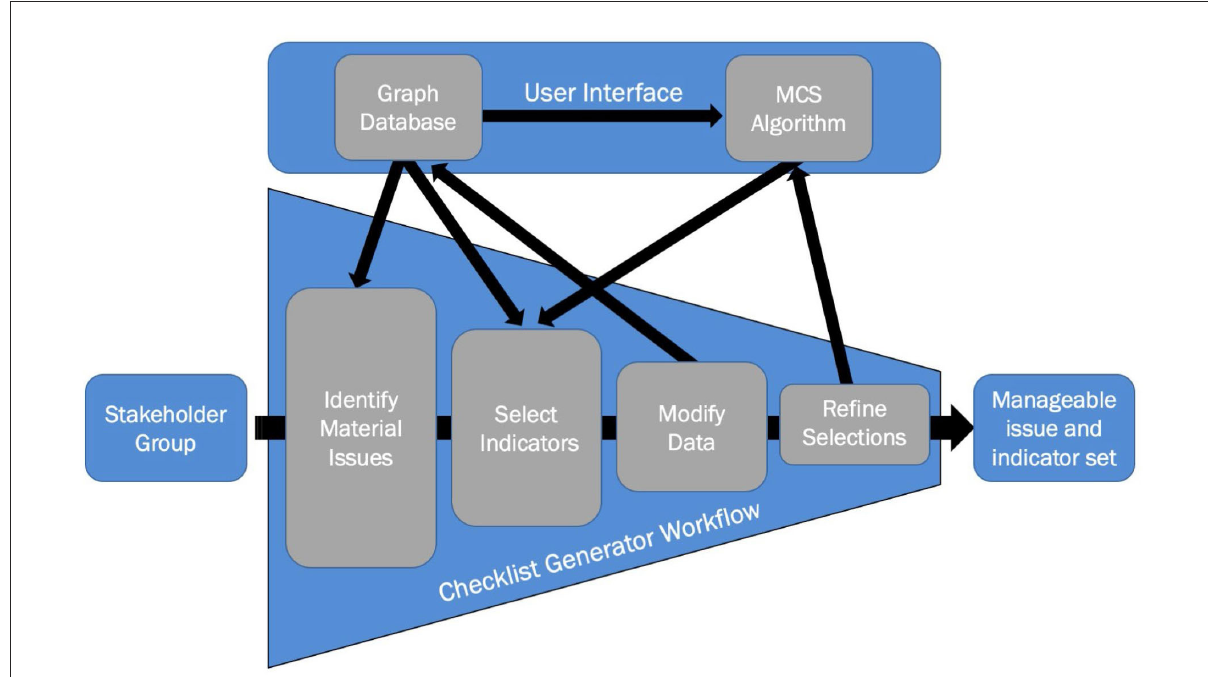
stories that show how the checklist generator workflow could unfold. The main goal of presenting three different hypothetical cases is to show how this workflow is malleable depending on the specific commodity and region, as well as the goals of the stakeholders involved. Note that these stories are only illustrative of our workflow template and do not represent outcomes of real